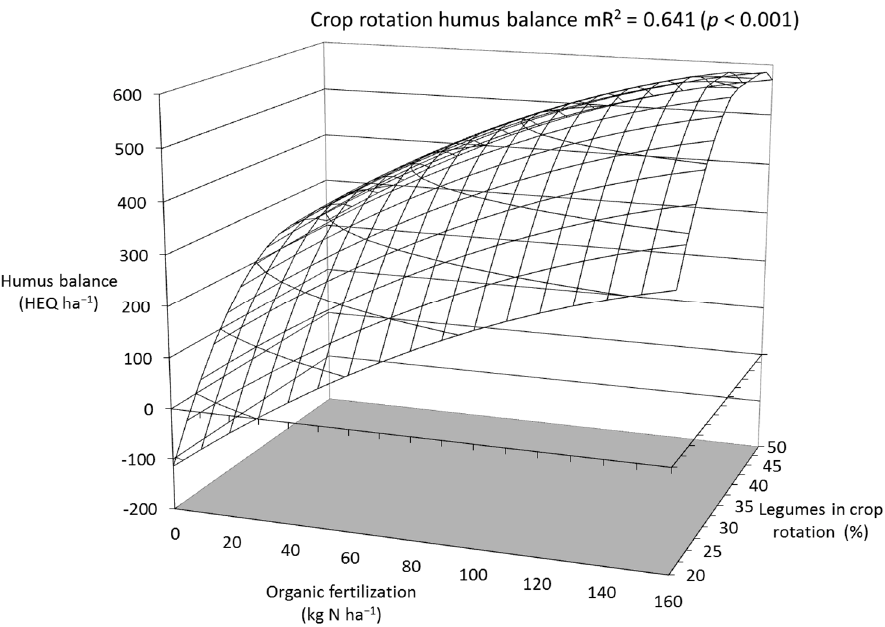
Figure 5. Effects of increasing organic N fertilization and legume proportions in crop rotations on the results of humus balancing on heavy soils.